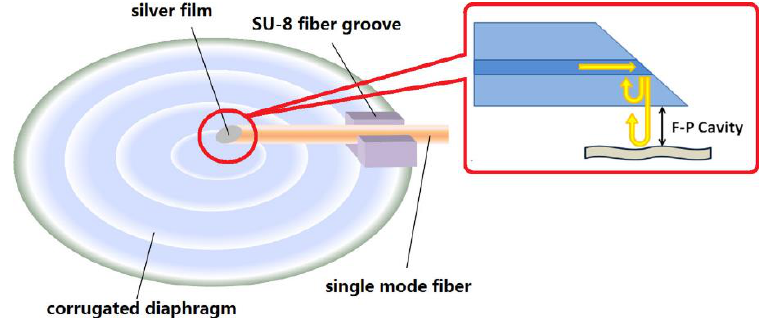
Figure 8. Sketch of the fiber-optic F-P pressure sensor. (Reproduced from [20] ).